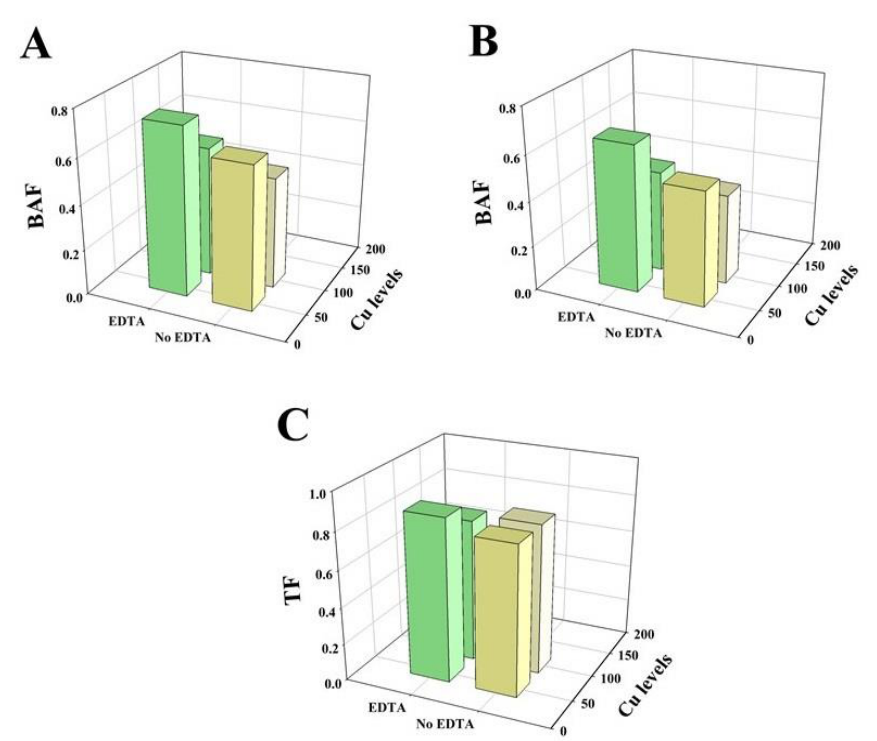
Figure 4. Effect of different concentrations of Cu and with or without the application of EDTA on bioaccumulation factor in roots ( A ), bioaccumulation factor in shoots ( B ) and translocation factor in the shoots ( C ) of C. capsularis seedlings grown in solution mixture with increasing Cu concentrations (0-, 50- and 100- μM) treated with and without 3-mM EDTA.